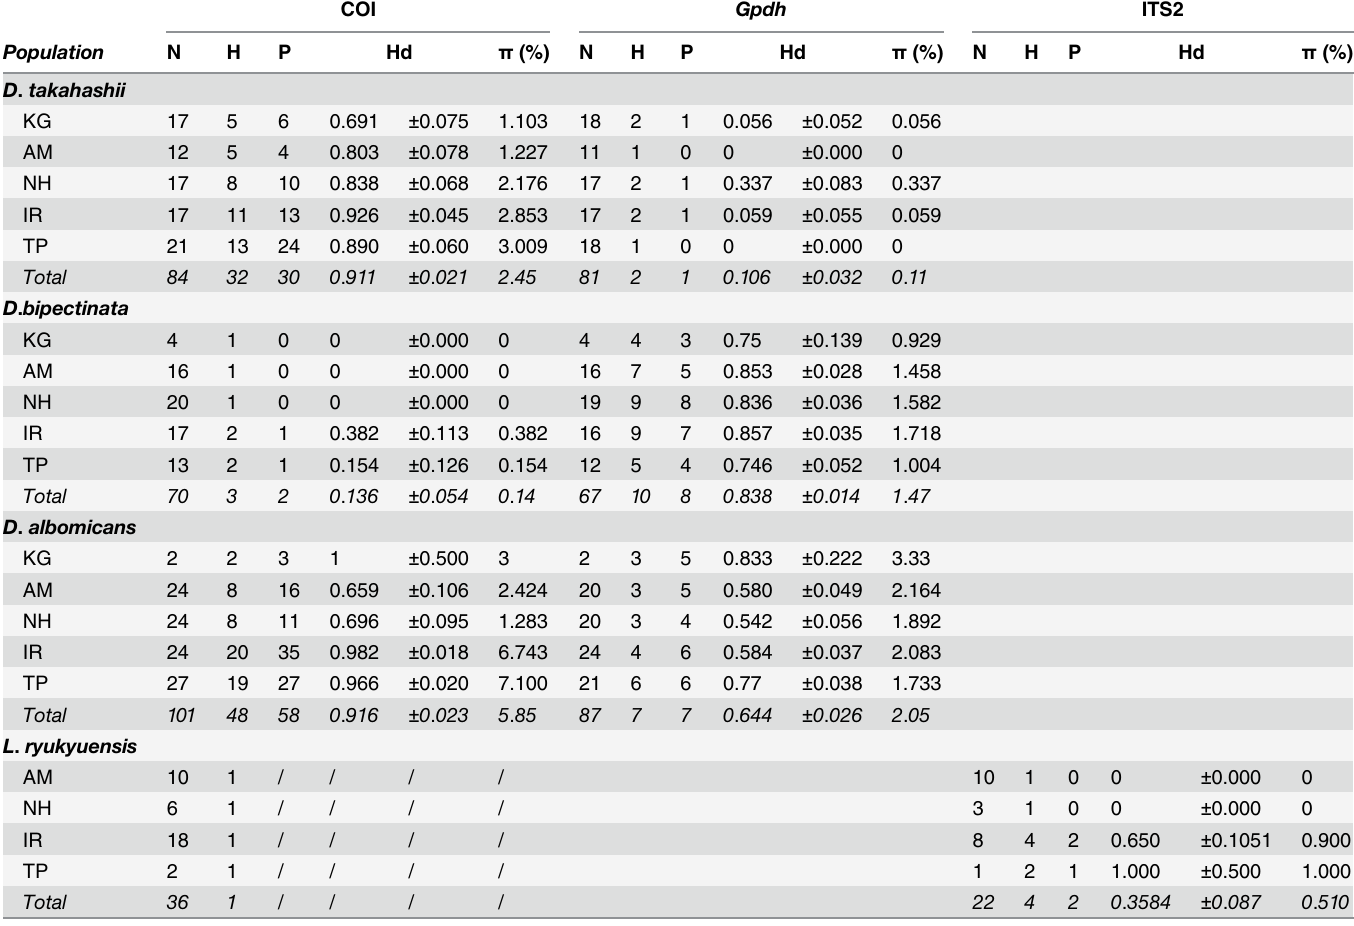
Table 1. Sample sizes and summary of the DNA polymorphism measures for Drosophila takahashii , D . bipectinata , D . albomicans , and Leptopilina ryukyuensis in the Ryukyu archipelago and